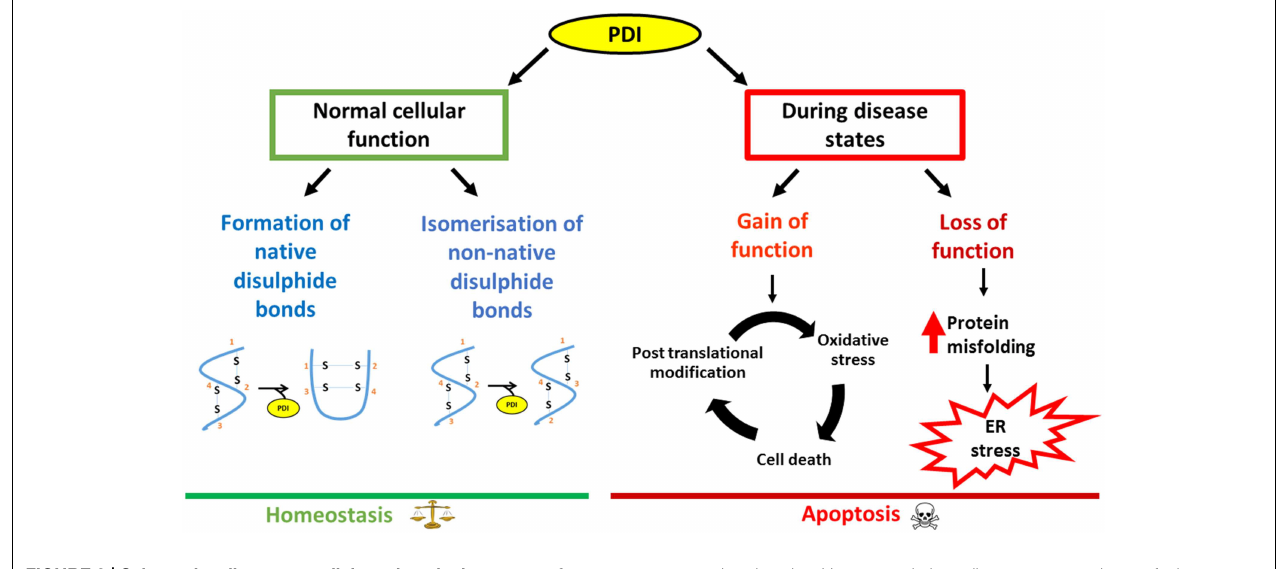
non-native bonds. However, during disease states, loss of the normal protective function of PDI as well as the gain of additional, toxic functions, leads to PDI becoming apoptotic, thus contributing to pathology.